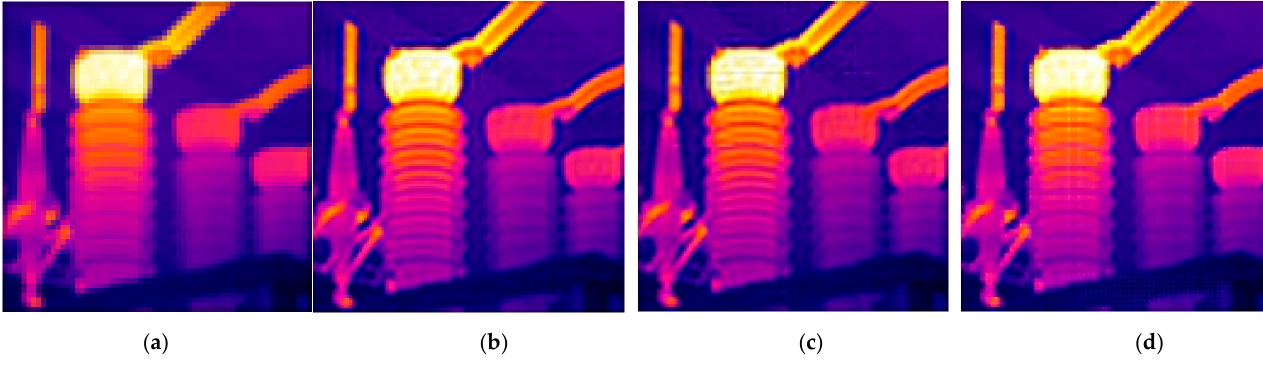
Figure 9. Reconstruction results of different block compressed sensing algorithms: ( a ) LR image; ( b ) image reconstructed by TwTVSI algorithm; ( c ) image reconstructed by BCS-L1 algorithm; ( d ) image reconstructed by BCS-TV algorithm.